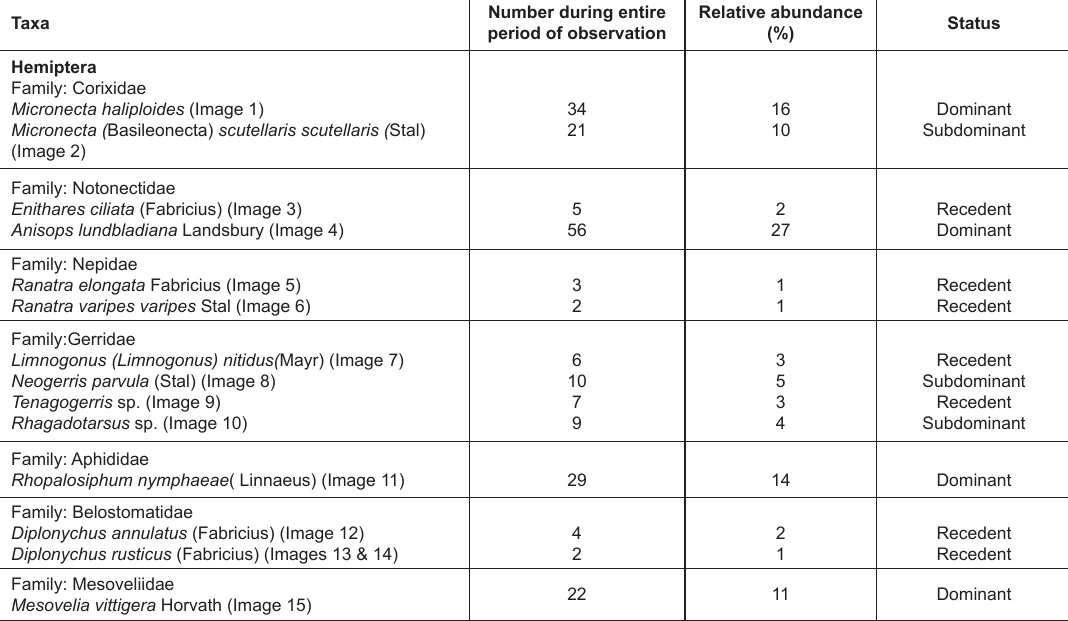
Table-2. Dominance status of different species of Hemiptera community RA <1-Subrecedent; 1.1–3.1-Recedent; 3.2–10-Subdominant;